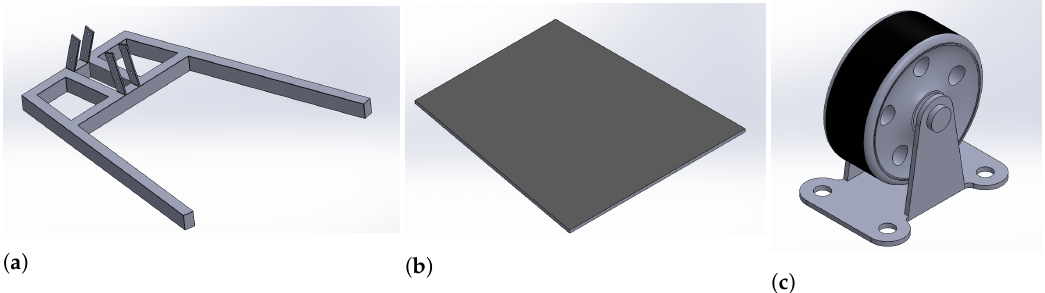
Figure 2. Items used for mechanical design; ( a ) base frame, ( b ) base plate, and ( c ) wheel. Dimensions for the base frame are given in Figure